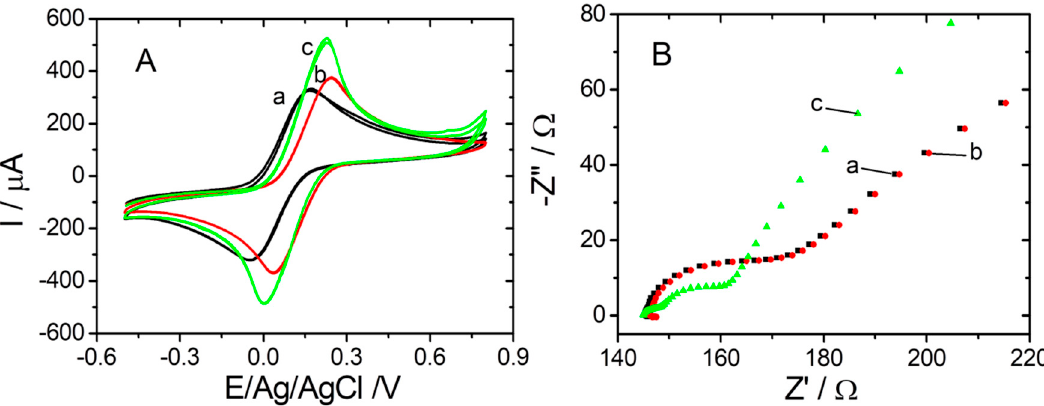
Figure 2. ( A ) CVs and ( B ) EIS spectra recorded for graphite SPE modified with graphene (black (a)); graphite SPE modified with graphene reduced (red (b)); and graphite SPE modified with graphene reduced and AuNPs (green (c)) in 10 mM [Fe(CN) 6 ] 3 − /4 − in 20 mM PBS pH 7.4.